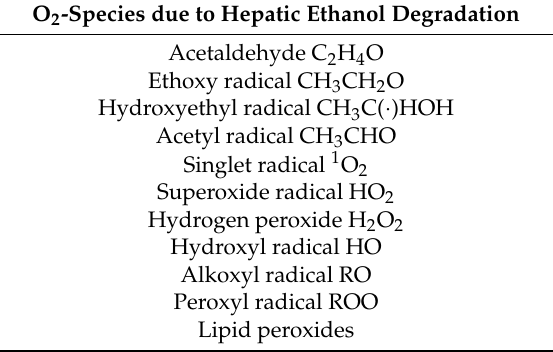
Table 5. Potentially toxic metabolites resulting from the enzymatic degradation of ethanol in the liver Derived from original reports and review articles